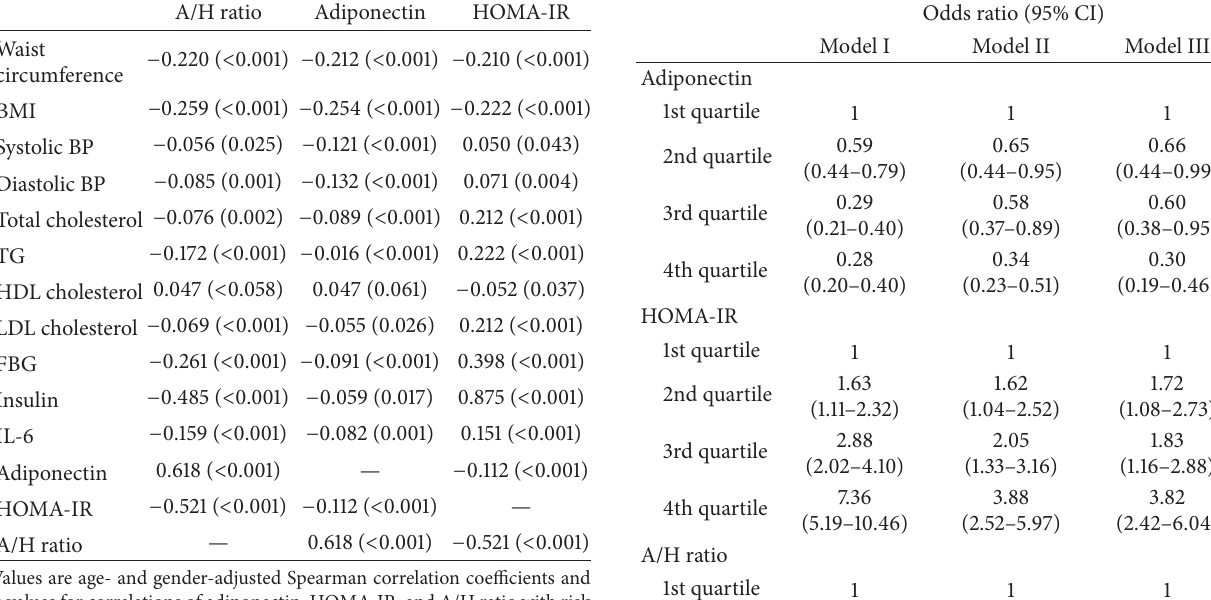
Table2:Partialcorrelationanalysisamongadiponectin,HOMA-IR, A/H ratio, and risk factors of MetS.